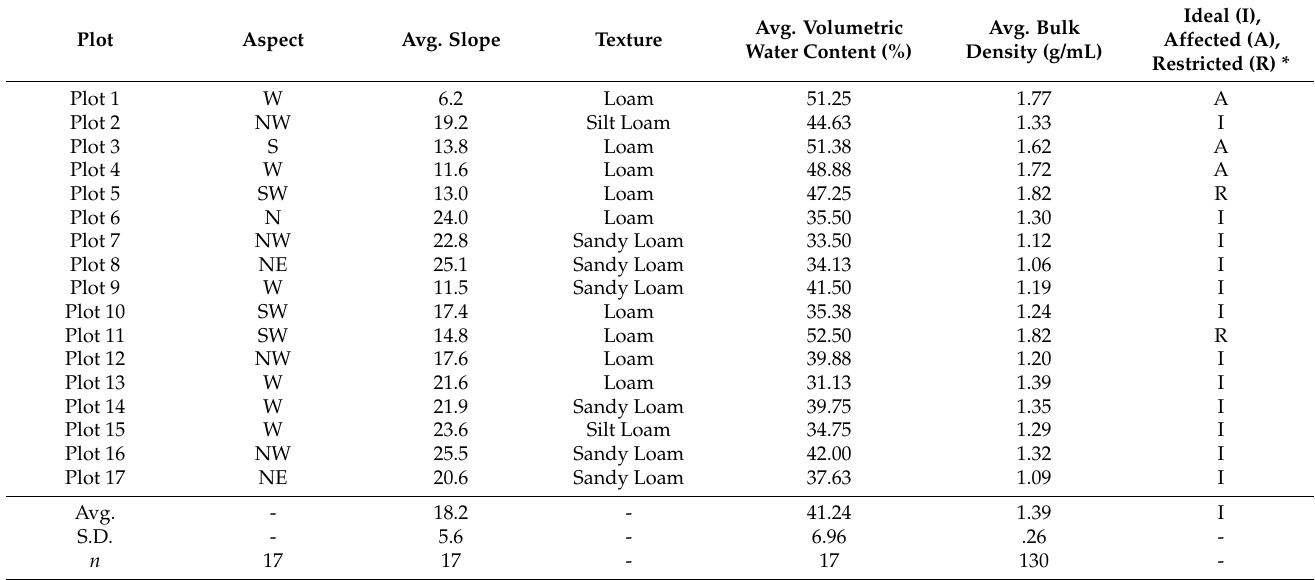
Table A3. Soil volumetric water content, bulk density, and texture analyses and relationships to plot aspect, average slope, and plant root growth.